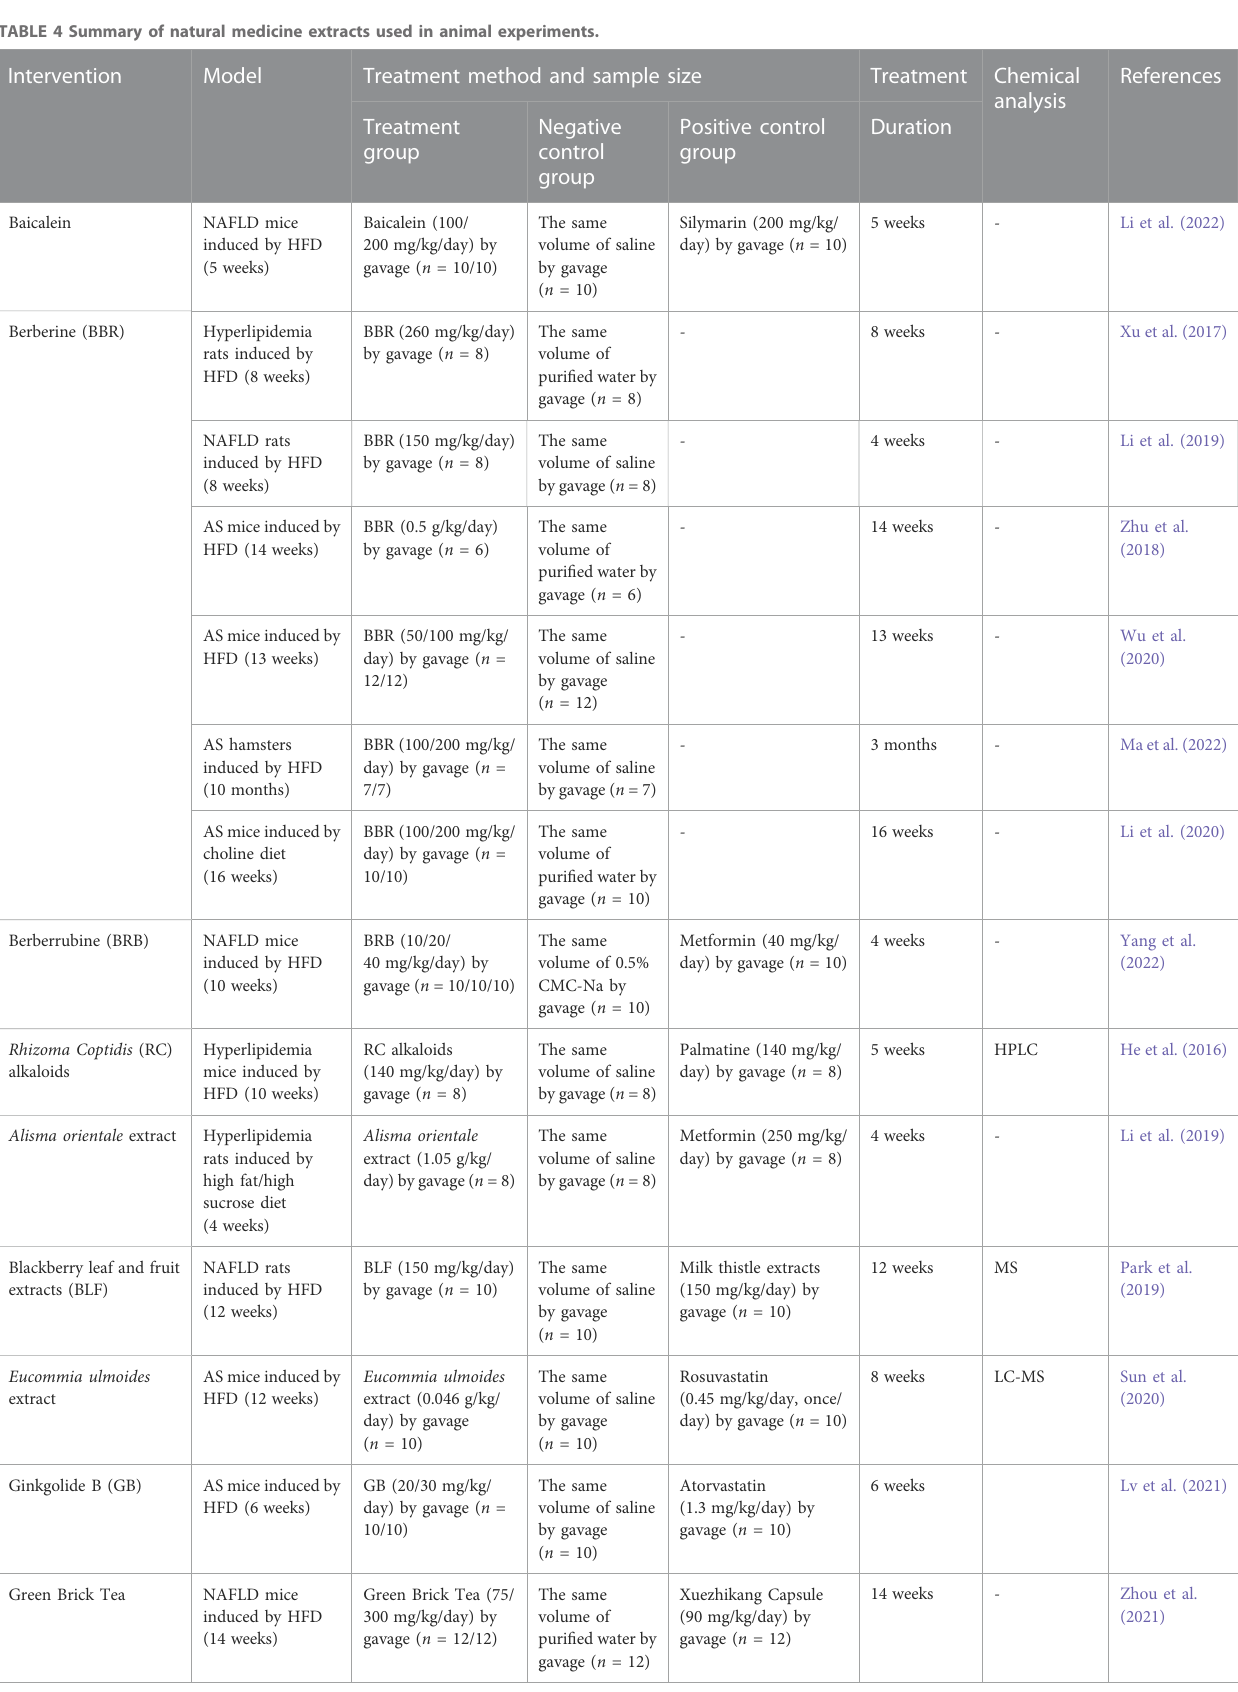
TABLE 4 Summary of natural medicine extracts used in animal